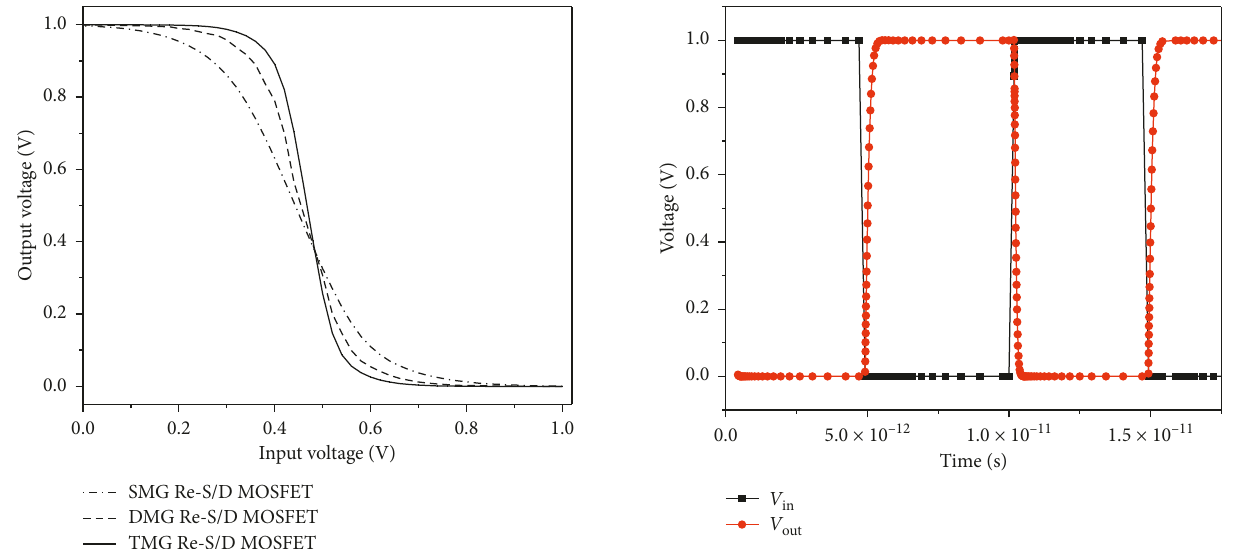
Figure 19: Transient analysis of pseudo-NMOS for TMG Re-S/D FD SOI MOSFET at 90nm channel length. Table 3: Comparison of delay of inverters at 90nm channel length.